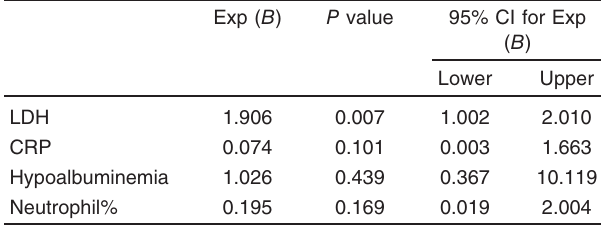
Table 6 Logestic regression to predict worse